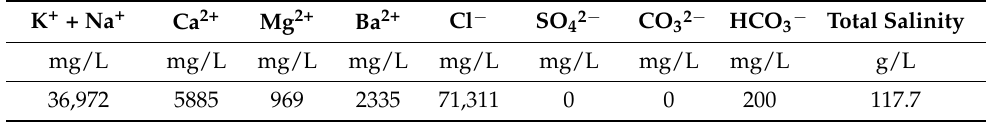
Table 2. Composition of the experiment